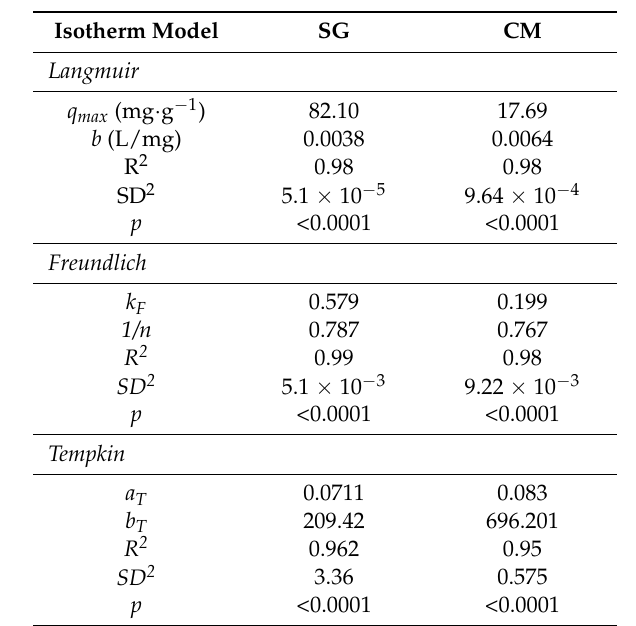
Table 1. Calculated Constants and Parameters of the isotherm models for the adsorption of phenol onto Sargassum sp. (SG) and Chaetomorpha (CM)